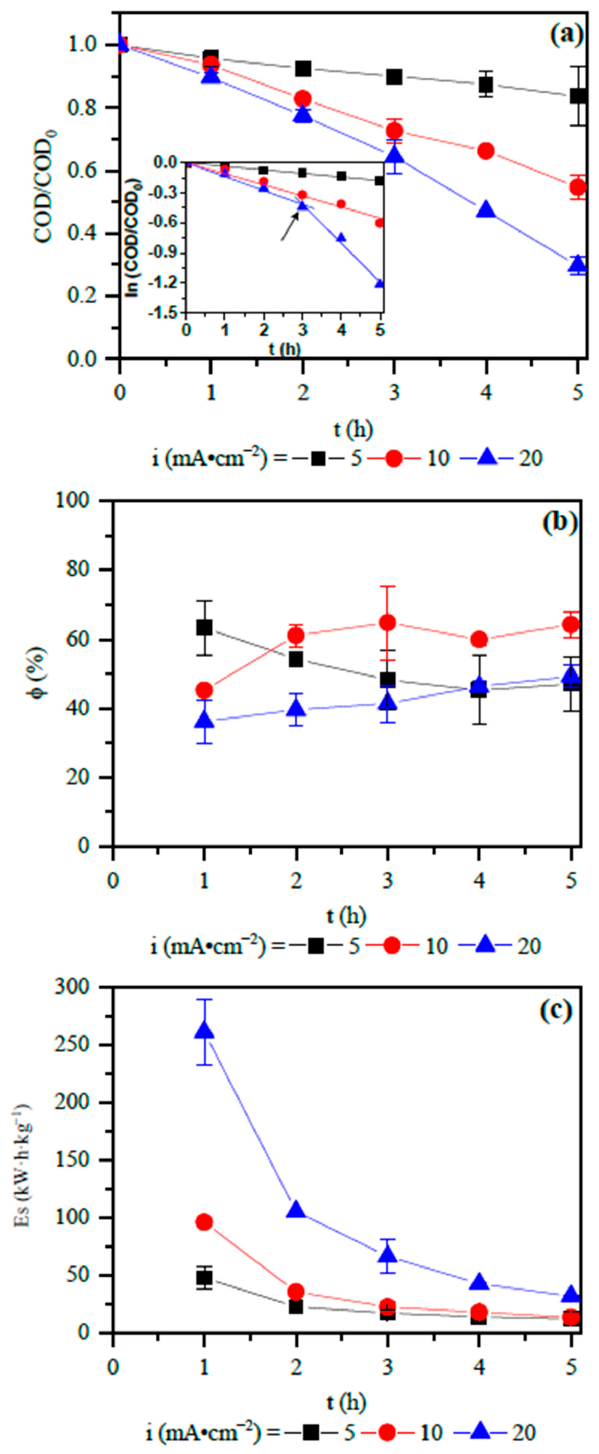
1 Figure 3. Influence of applied current densities in: ( a ) normalized chemical oxygen demand (COD)